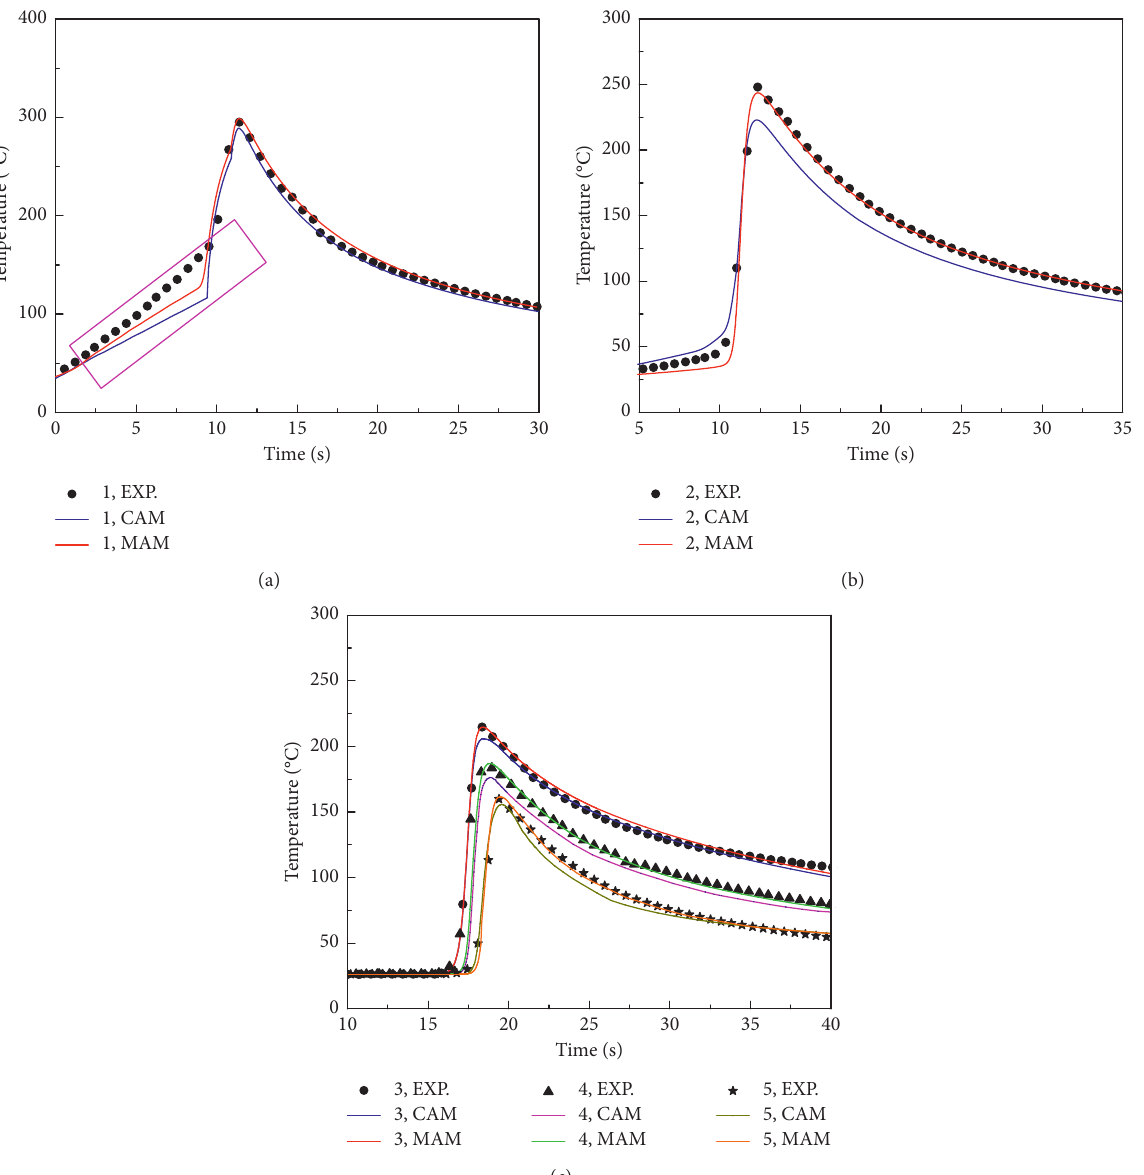
Figure 14: Comparison between the predicted and measured thermal cycles in different stages. (a) Plunge stage; (b) traverse stage (unsteady stage); (c) traverse stage (steady